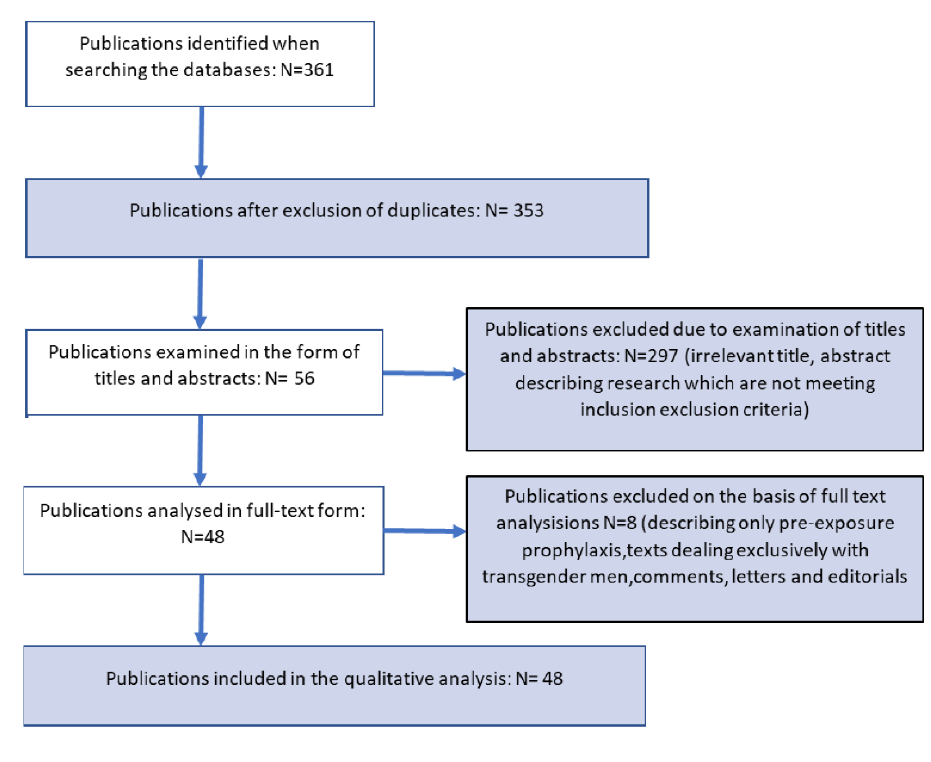
Figure 1. Search strategy.